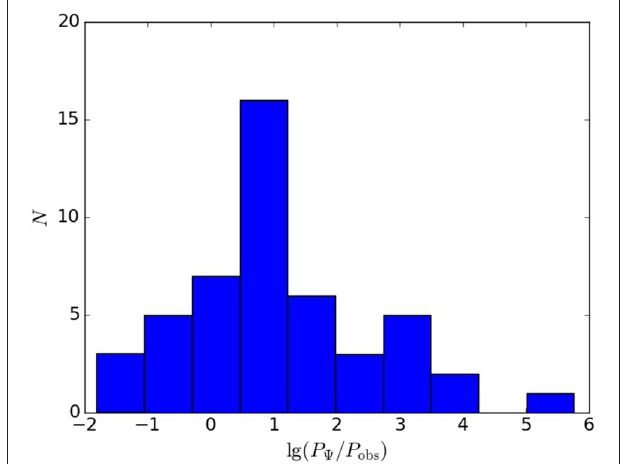
FIGURE 1 | The jet power P 9 , calculated using magnetic flux, against the total kinetic jet power. The straight line is a theoretical prediction. The blue circle stand for the total flux obtained using the core shift effect, the red crosses are for the total flux obtained using the brightness temperature. The sources with the flux approximately equal to the MAD flux are in the upper left corner.